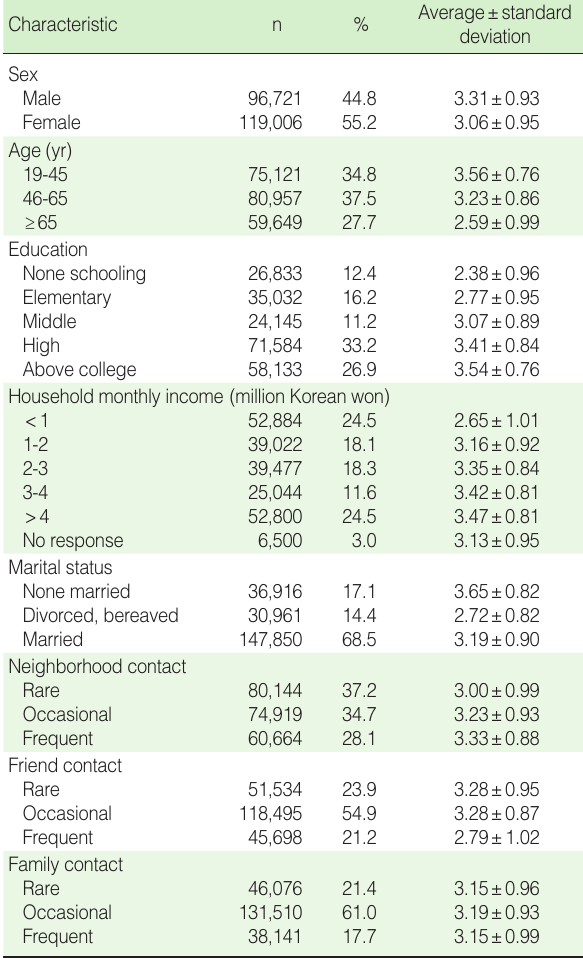
Table 1. Basic characteristics of the subjects